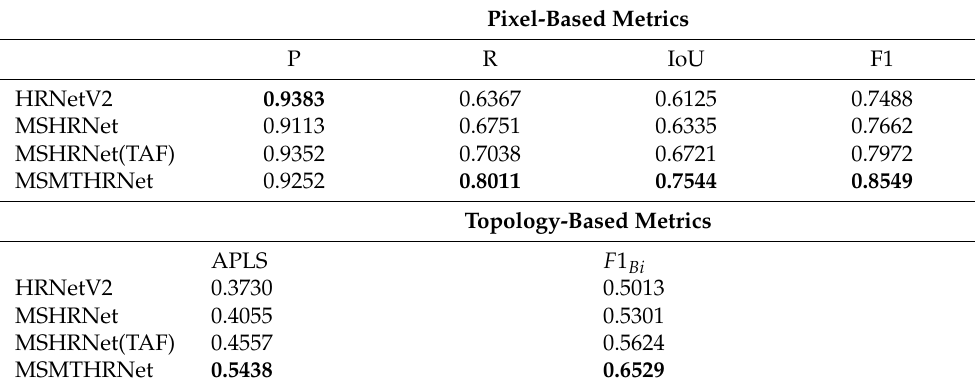
Figure 7. HRNetV2 is baseline method; MSHRNet is modify the baseline method with multiscale fusion module. MSMTHRNet(TAF) use the image after temporal average filter. Table 2. Comparative quantitative Evaluation Among Different Methods for Road Detection on our dataset. It should be noted that the results are the average performance of all images in the test set. A higher value indicates a better performance. With the best results marked in